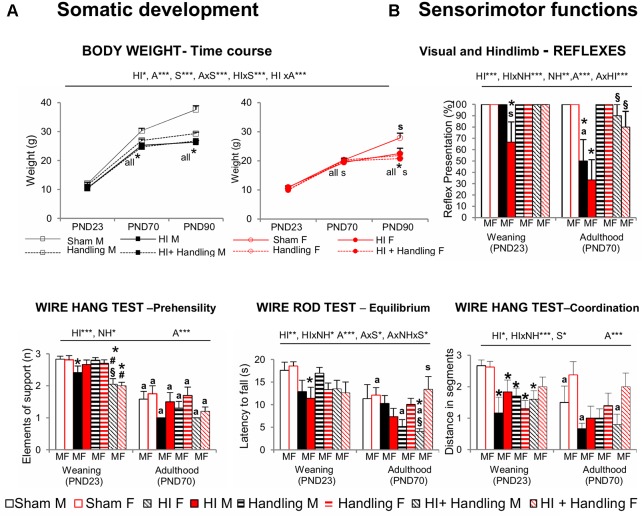
(A) Somatic development [postnatal day (PND)23–PND90] and (B) sensorimotor functions (PND23–PND70). Short- and long-effects of HI in males and females C57BL6 and effects of neonatal handling (NH). Results are presented as mean ± SEM. HI animals presented slower weight gain, with male being more sensitive than female; handling could not reverse the hypoxia’s effect. At sensorimotor level, HI impaired visual and hindlimb reflexes, which were first shown in females (PND23). Equilibrium, prehensility and coordination were also affected. Handling modulated the impaired reflex responses and an interaction with HI was also seen in other sensorimotor functions. Statistics: RMA, two-way ANOVA: “HI” Hypoxia effect; “NH” handling effect; “S” sex effect; “A” age effect *P < 0.05, **P < 0.01, and ***P < 0.001, followed by Duncan’s post hoc test. *P < 0.05 vs. sham of the same sex; #P < 0.05 vs. handling of the same sex; §P < 0.05 vs. hypoxia of the same sex; sP < 0.05 female vs. male of the same treatment. Paired t-test comparison day 23 vs. day 70, aP < 0.05.